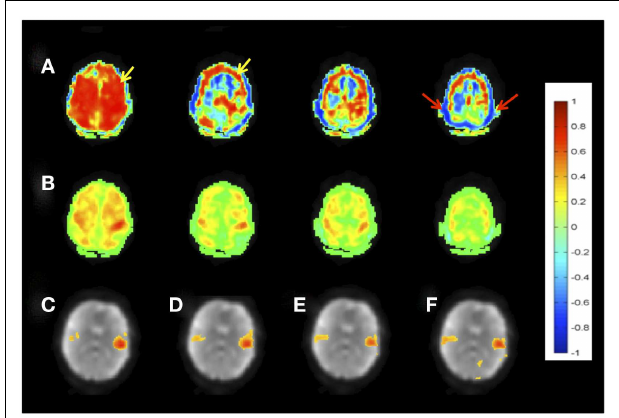
FIGURE 3 | Seed-based connectivity of the sensorimotor RSN measured with MEVI2 (TR: 136ms) . (A) Correlation across the entire 5min scan without regression of confounding signal changes displays widespread artifacts (yellow arrow) and edge artifacts due to head movement (red arrows). (B) Sliding-window correlation analysis with meta-statistics using a 4-s sliding-window removes the artifacts and reveals the expected localization of the sensorimotor network in the mean meta-statistics map. (C–F) Seed-based connectivity of the auditory RSN shown as mean meta-statistics across the 5min scan using sliding-window widths of (C) 15s, (D) 4s, (E) 2s, and (F)